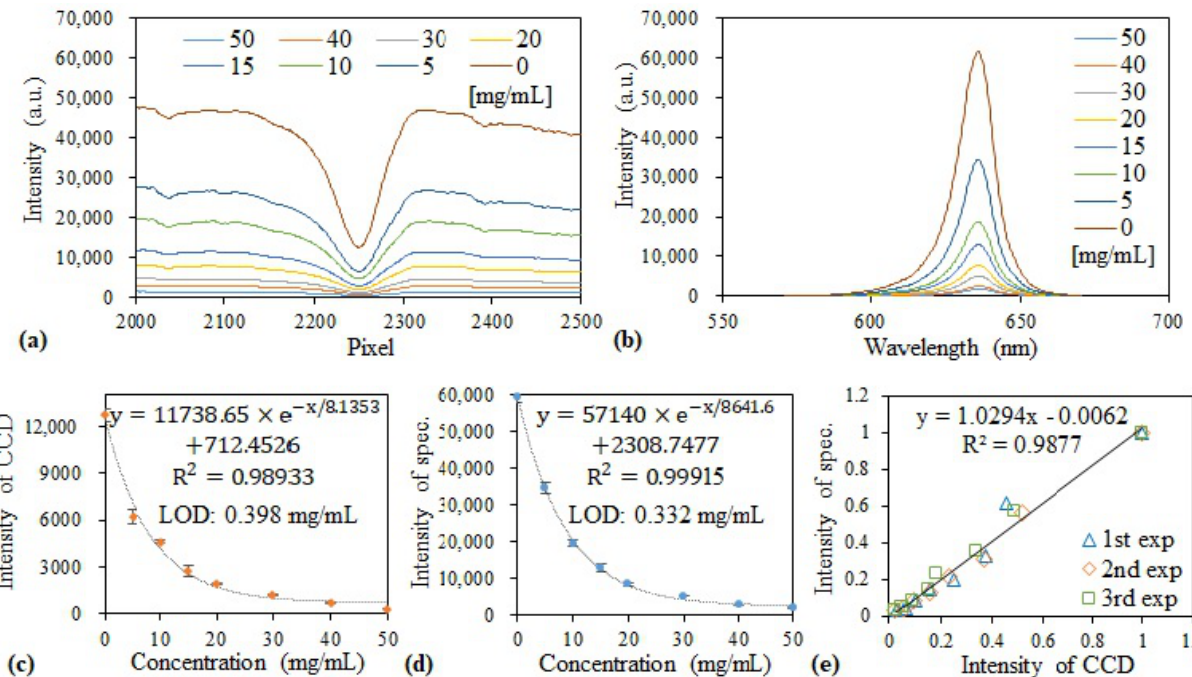
Figure 8. Transmission measured with the ( a ) GGP-GMR/CCD and ( b ) spectrometer. Dose response curves of the ( c ) MICP intensity and ( d ) peak wavelength intensity as functions of the albumin concentration. ( e ) Correlation between the two measurement